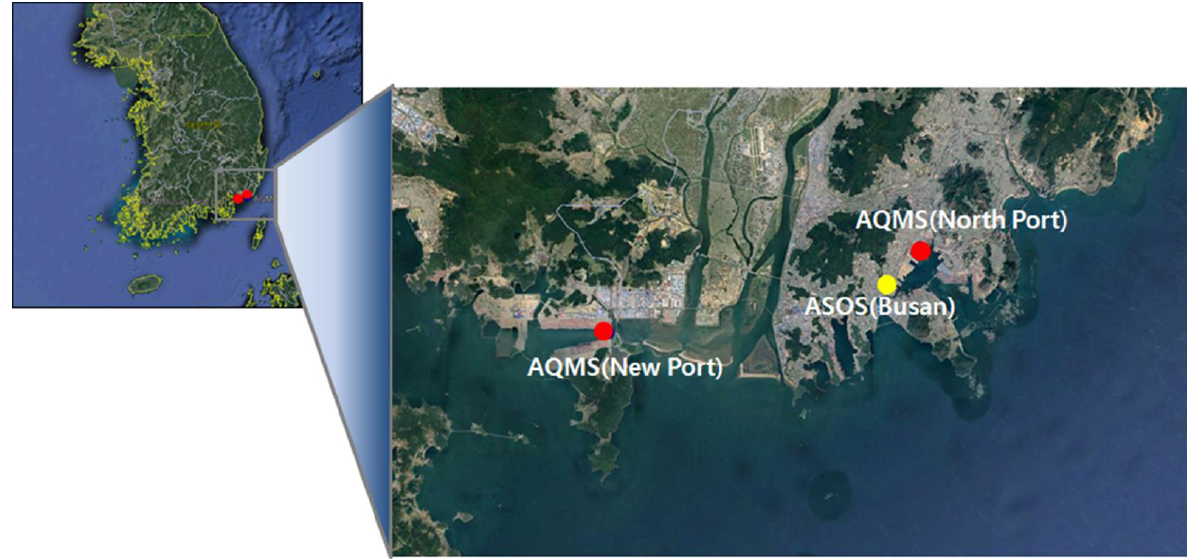
Figure 2. Locations of Air Quality Monitoring System (AQMS) sites and the Korea Meteorological Administration (KMA) Automated Synoptic Observing System (ASOS) site in Busan Port.